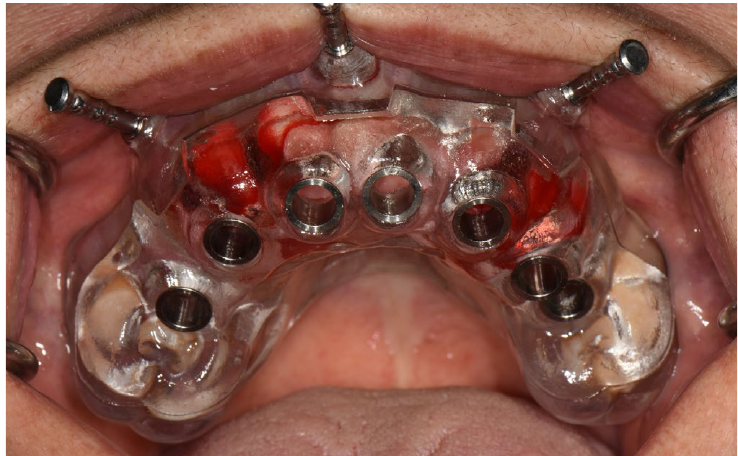
Figure 9. Provisional pre surgical prosthesis with esthetic characterization: palatal view ( a ), frontal view ( b ).